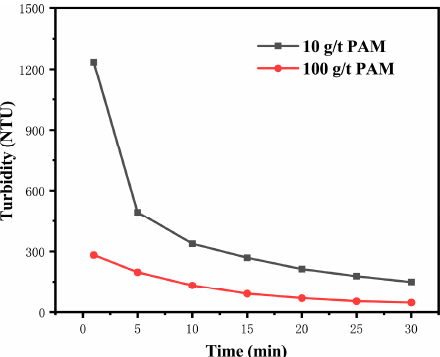
Figure 12. Supernatant turbidity of 1 wt.% -2000-mesh montmorillonite slurry during a 30-min sedimentation.